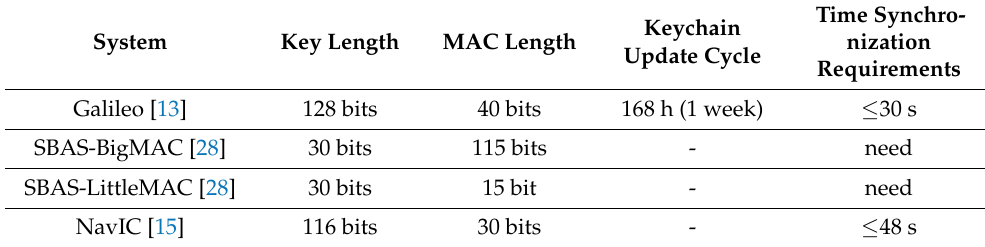
Table 7. Security design of TESLA protocol for typical satellite navigation system.